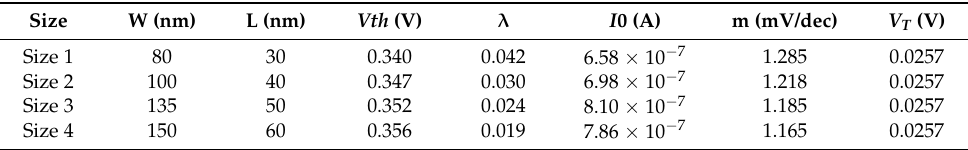
Table A1. Coefficients for NMOS in the case of different sizes.